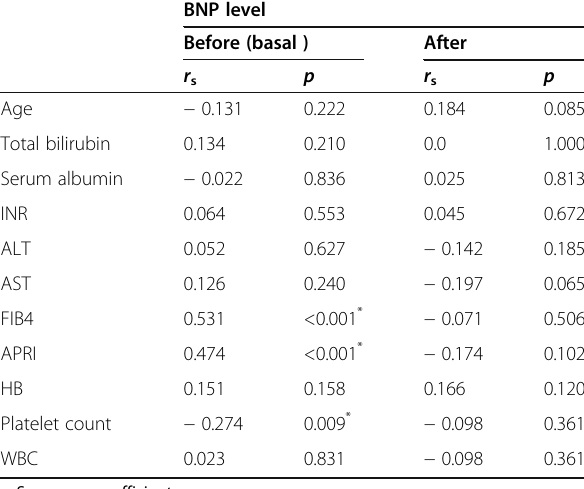
Table 3 Correlation between BNP (before and after treatment) level and different laboratory